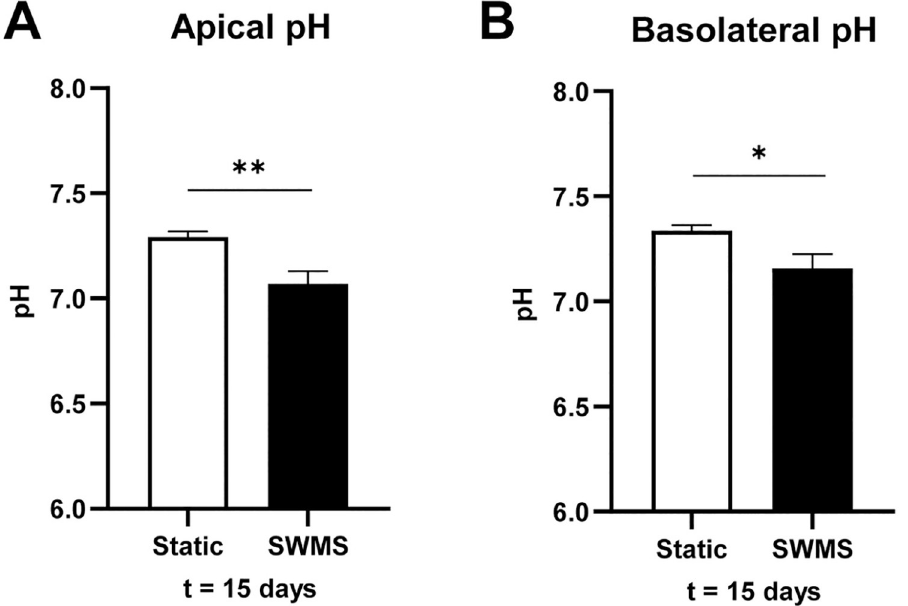
Fig 6. pH values of medium collected at t = 15 days from HT29-MTX-E12 cells grown under static and SWMS conditions. Medium pH of A) apical and B) basolateral compartments of HT29-MTX-E12 cells grown under static and SWMS conditions at t = 15 days. � p < 0.05; �� p < 0.01, n = 3 biological